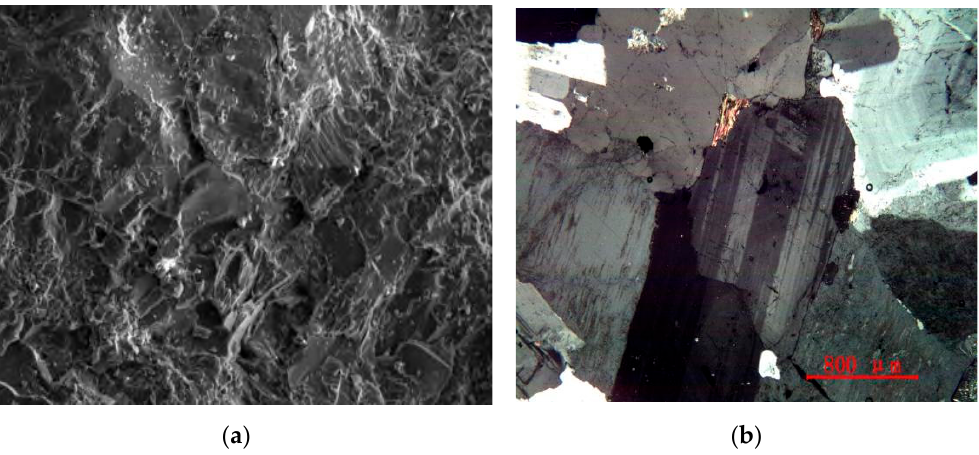
Figure 2. Mesoscopic characteristics of granite: ( a ) scanning electron microscopy micro ‐ structures (×500); ( b ) polarized light microstructures.